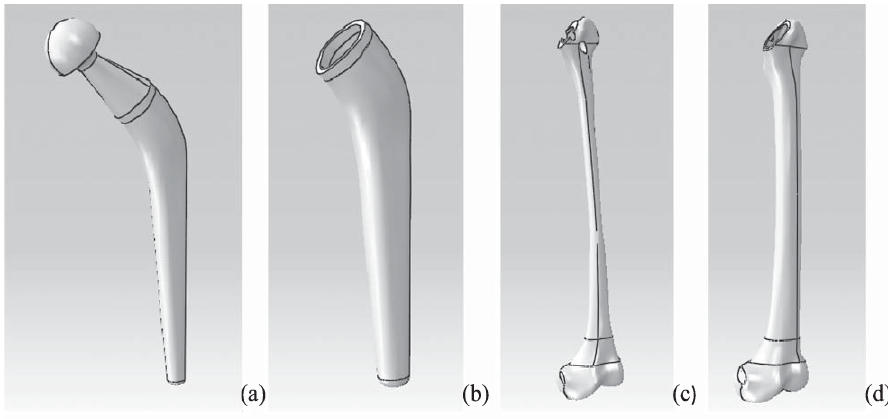
Fig. 3. The total hip